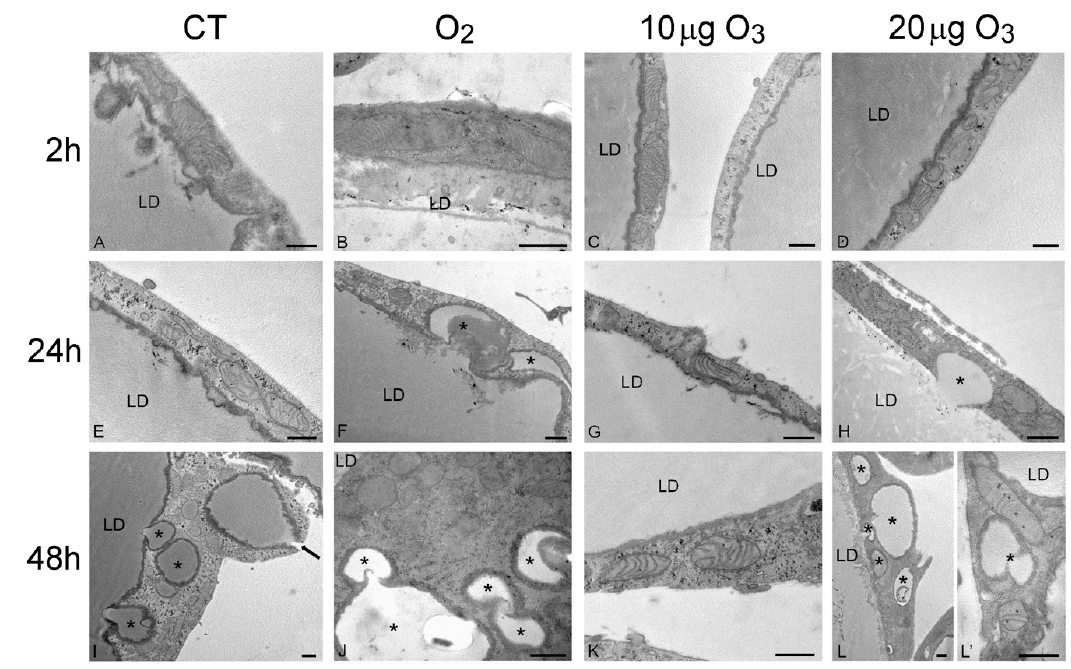
Figure 3. Transmission electron micrographs of the peripheral cytoplasmic rim of adipocytes 2 h ( A –